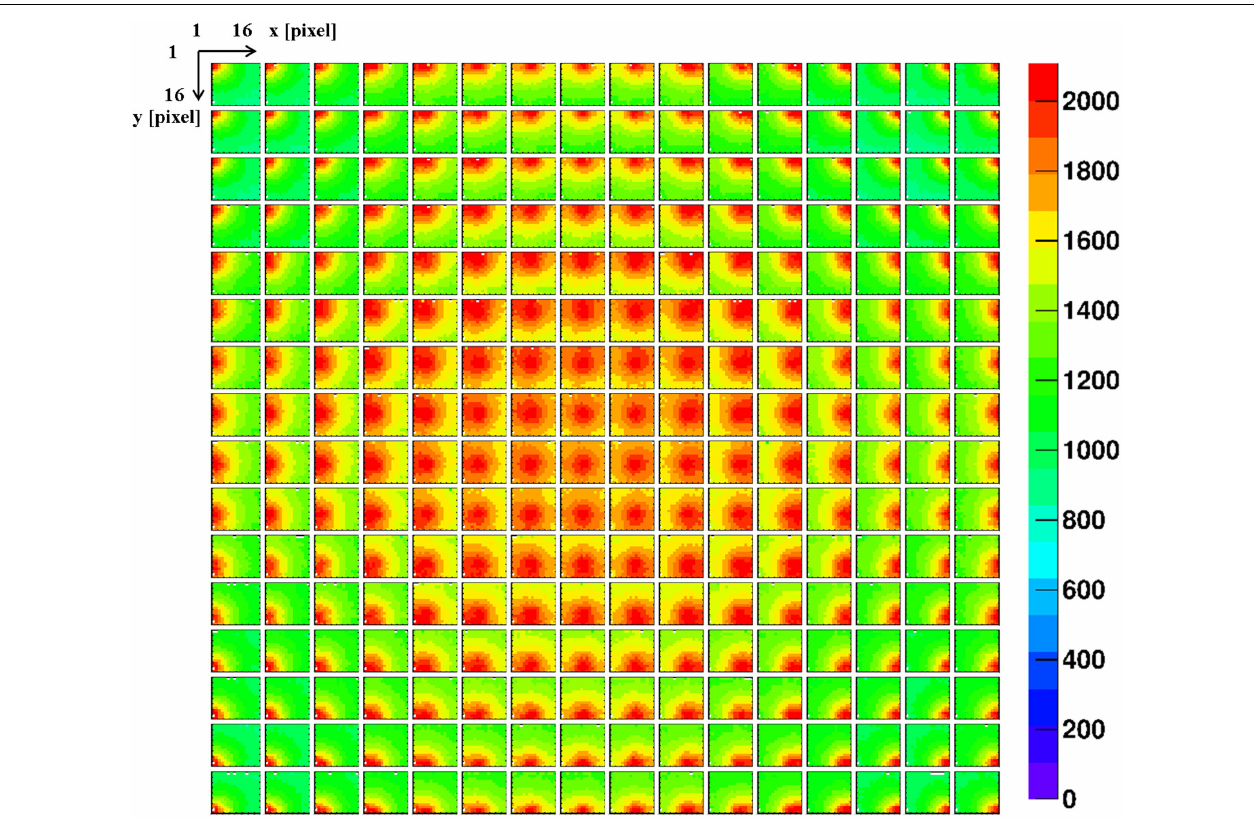
FIGURE 10 | A grid scan of 16 (cid:2) 16 irradiation positions of the reflectively coated monolithic LaBr 3 :Ce detector, using a 1mm collimated 137 Cs source and a grid step size of 3mm in x and y direction . All 256 segments of the multi-anode PMT are individually read out. The resulting 2D light amplitude distribution of each irradiation position clearly indicates a systematically different pattern for the 256 different source positions.